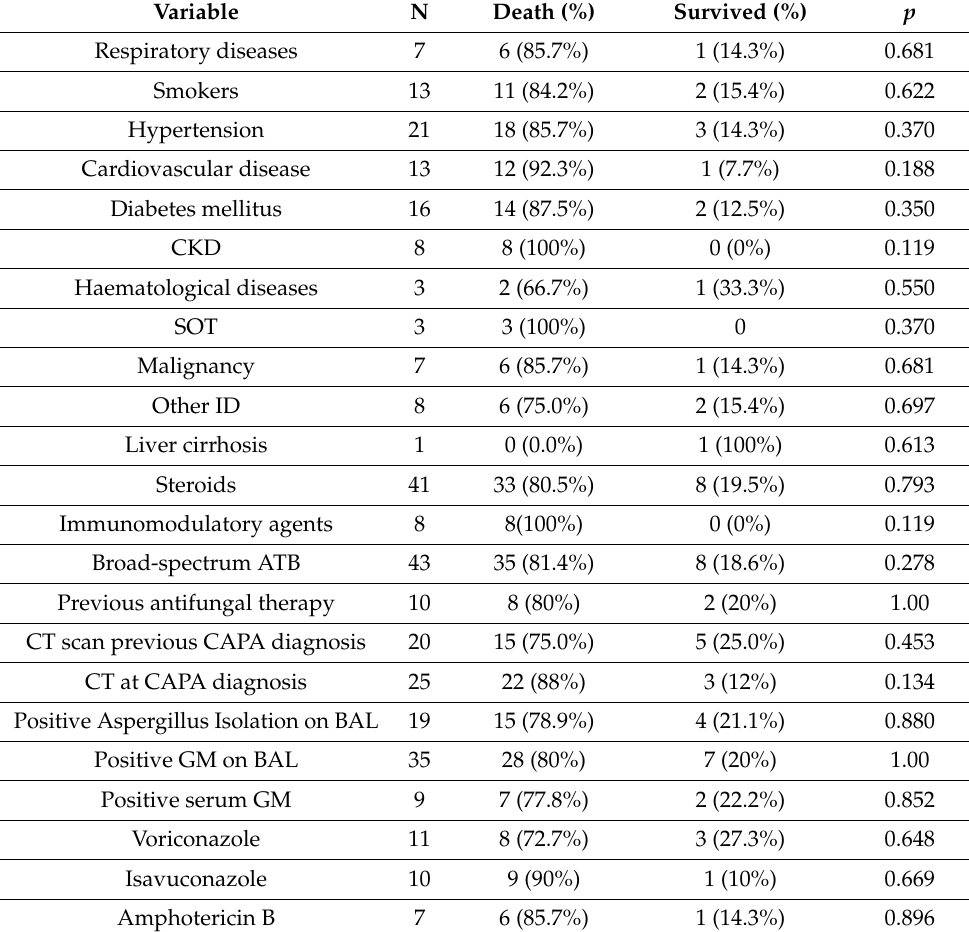
Table 6. Patients’ characteristics and risk factors for overall mortality of CAPA